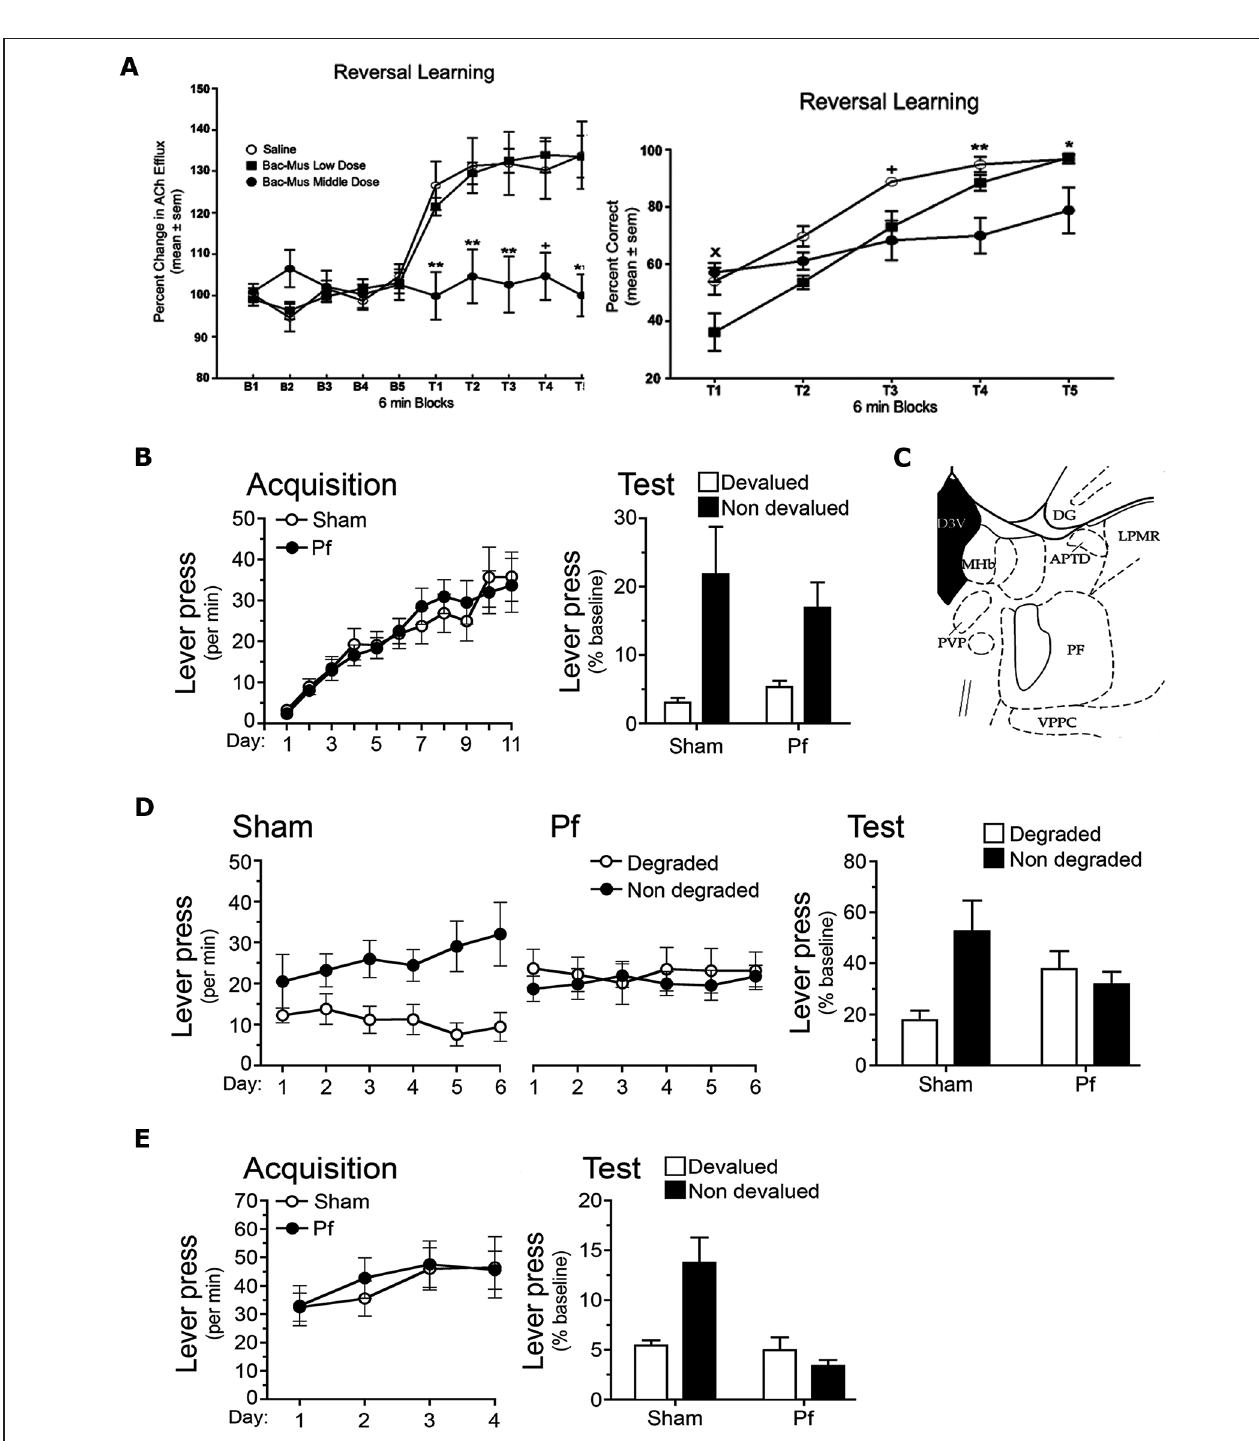
controls. (B,D,E) Reproduced from Bradfield and Balleine (2013), examines Sham and PF-lesioned animals. (B) Mean ± SEM responding per min during acquisition (left panel) and on an outcome devaluation test (right panel) of initial R-O contingencies. (C) Reproduced from Paxinos and Watson (1998). Schematic showing PF at A/P: − 4.16 from Bregma. (D) Mean ± SEM responding per min during contingency degradation training (left and middle panels) and on the extinction test (right panel). (E) Mean ± SEM responding per min during acquisition (left panel) and test (right panel) of reversed R-O